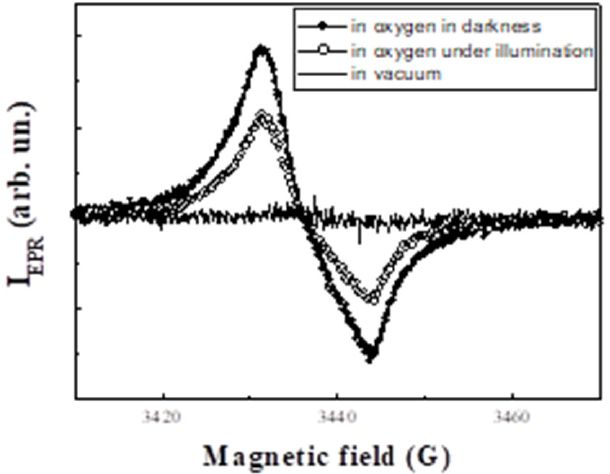
Figure 32. Electron paramagnetic resonance (EPR) spectra of por-Si powder in vacuum and in oxygen ambient ( P ox = 760 Torr) in darkness and under illumination. Measurements were done at high microwave power of about 200 mW. (Reprinted from Reference [84] with permission from Elsevier).